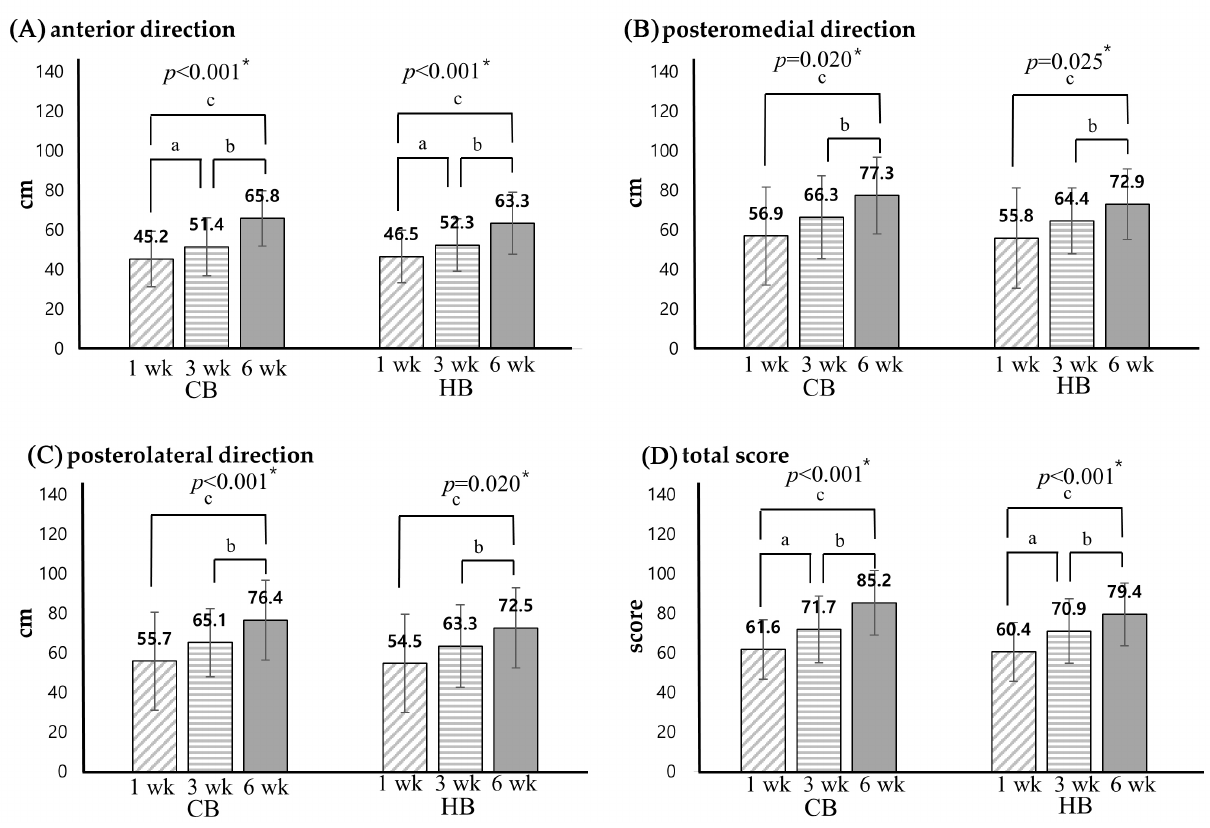
Fig. 3. Y-balance test of the CB training and HB training groups. * p < 0.05; a, b, and c mean the significance between measurement weeks (a, 1 week versus 3 weeks; b, 3 weeks versus 6 weeks; c, 1 week versus 6 weeks); CB, center-based; HB,